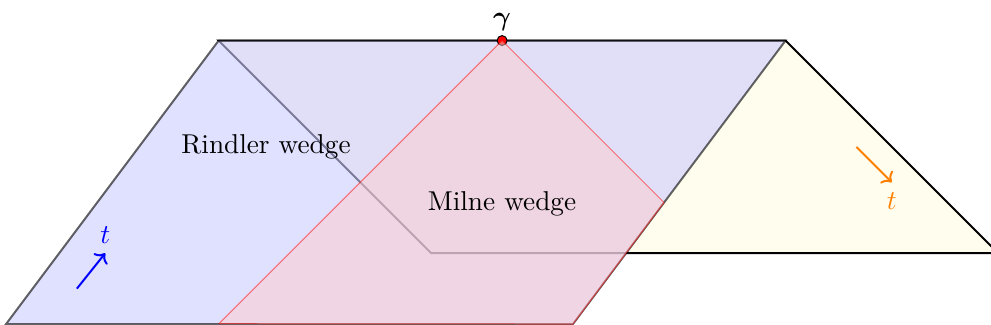
has a fixed point n